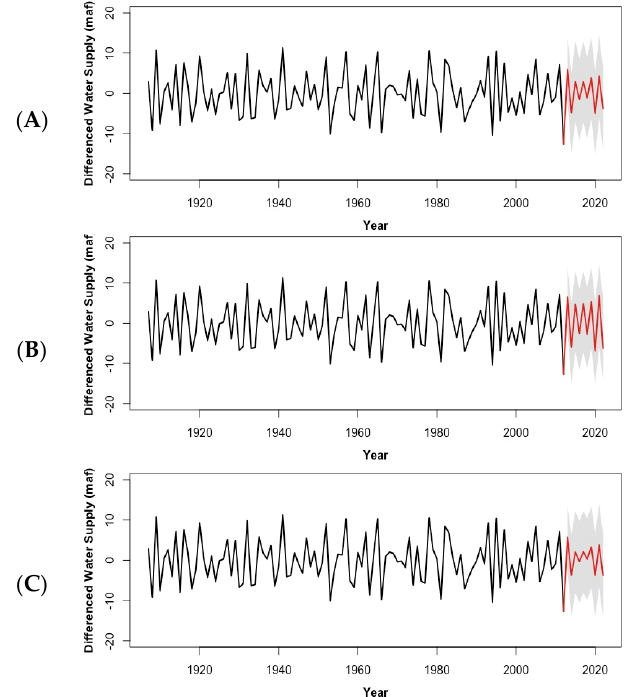
Figure 10. Plot of the observed values (black) with the predictions (red) ten years out for ( A ) SAR (19) model, ( B ) SARX (19, 1, 0) model, and ( C ) ARMAX (19, 1, 2, 0) model in million acre feet (maf). The gray shaded area denotes the 95% predicting confidence interval.